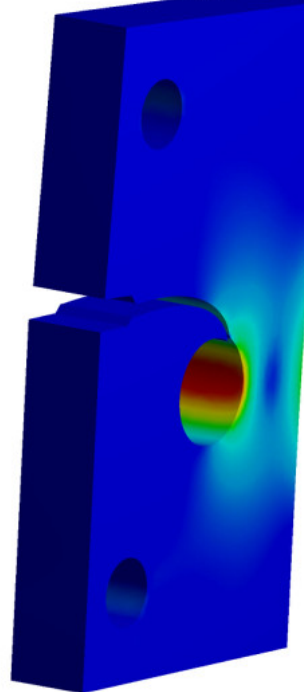
Figure 14. The equivalent elastic strain distribution.